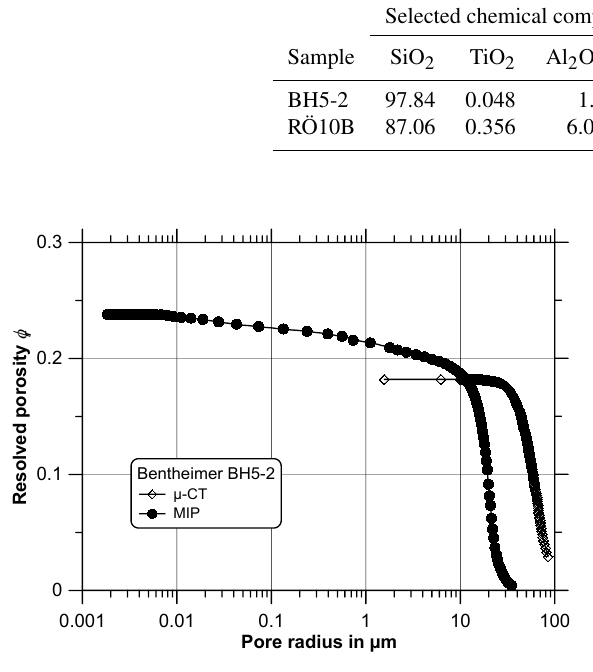
Figure 3. The recognized porosity and pore size range of Ben- theimer sandstone sample BH5-2. The maximum porosity recog- nized by MIP is 0.238 and the maximum porosity recognized by µ -CT is 0.184.